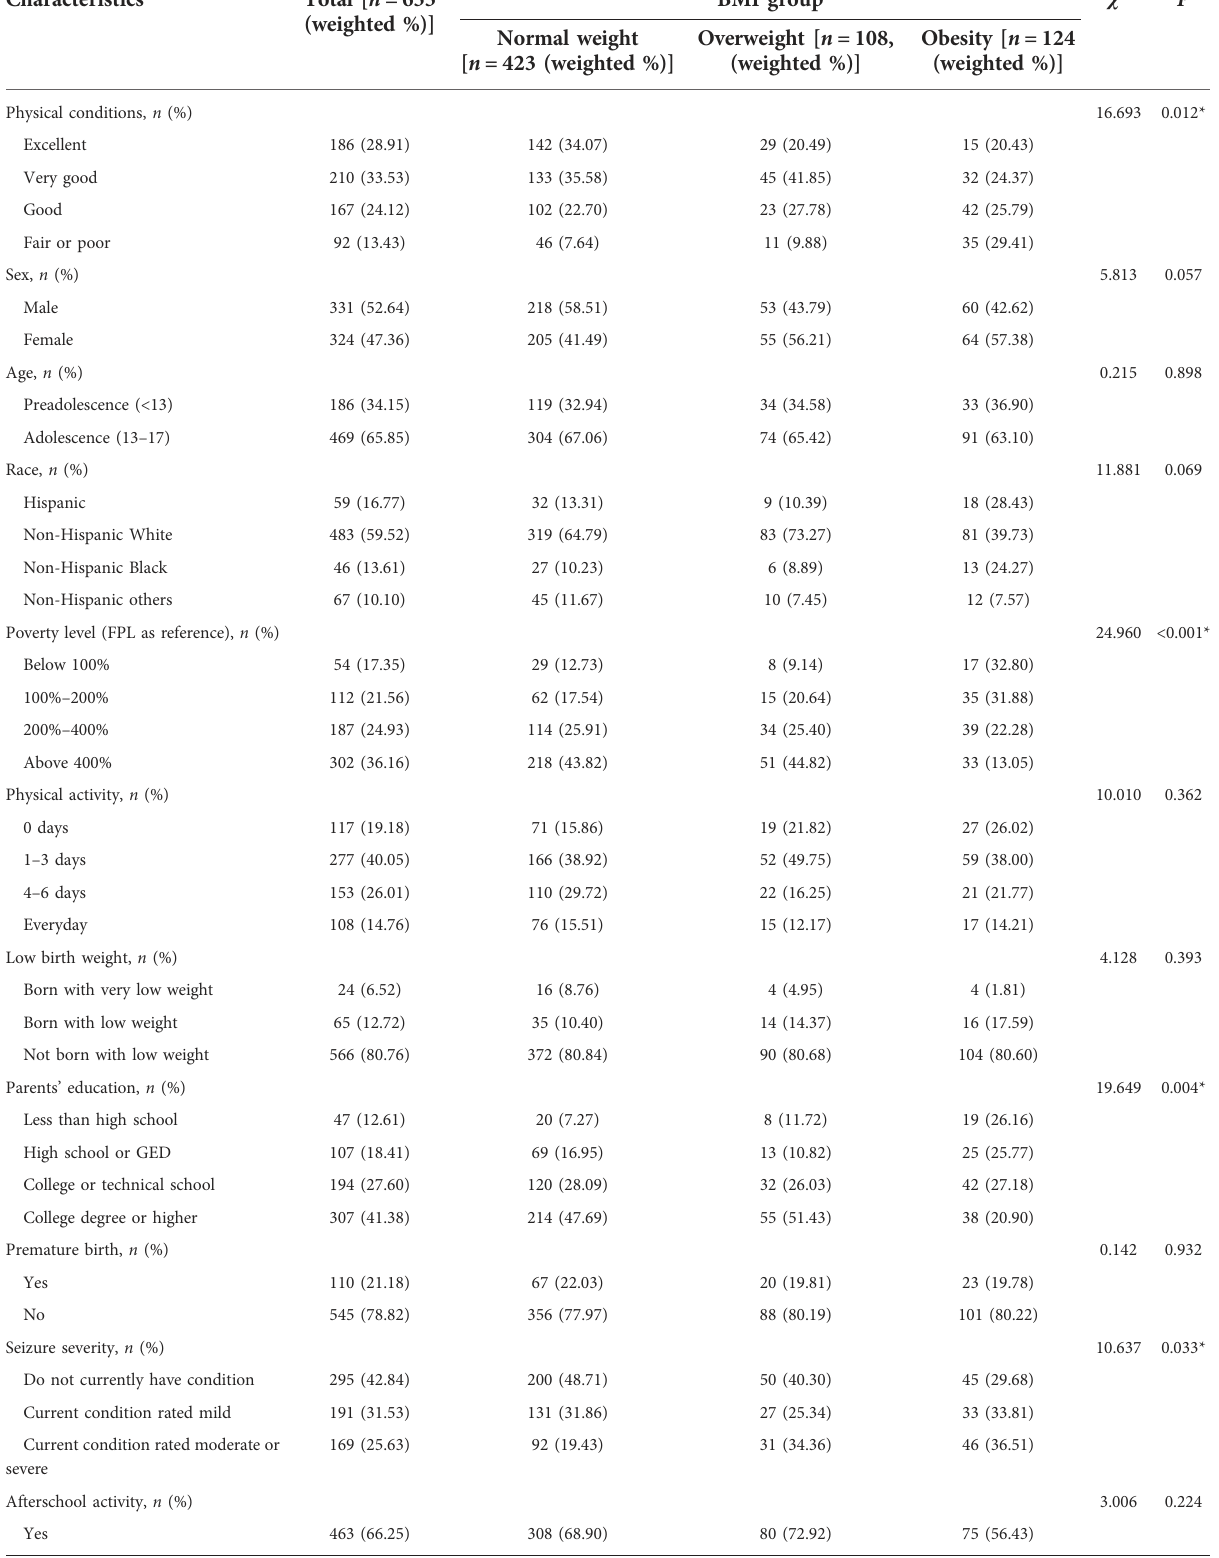
TABLE 1 Characteristics of children with epilepsy 10 – 17 years according to normal, overweight, and obesity status from the NSCH 2016 – 2017 and 2018 – 2019.